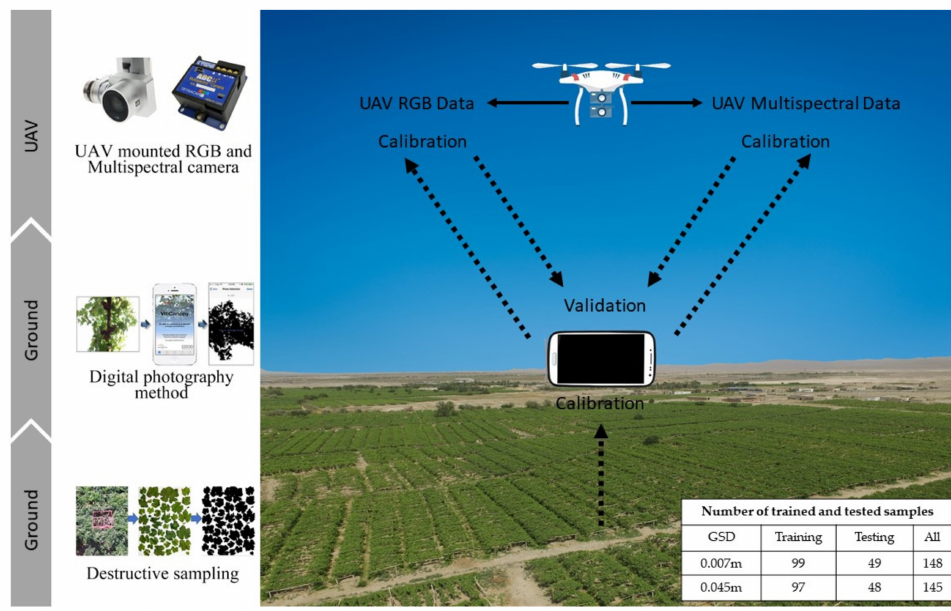
Figure 4. An overview of workflow in this study, and datasets used for constructing